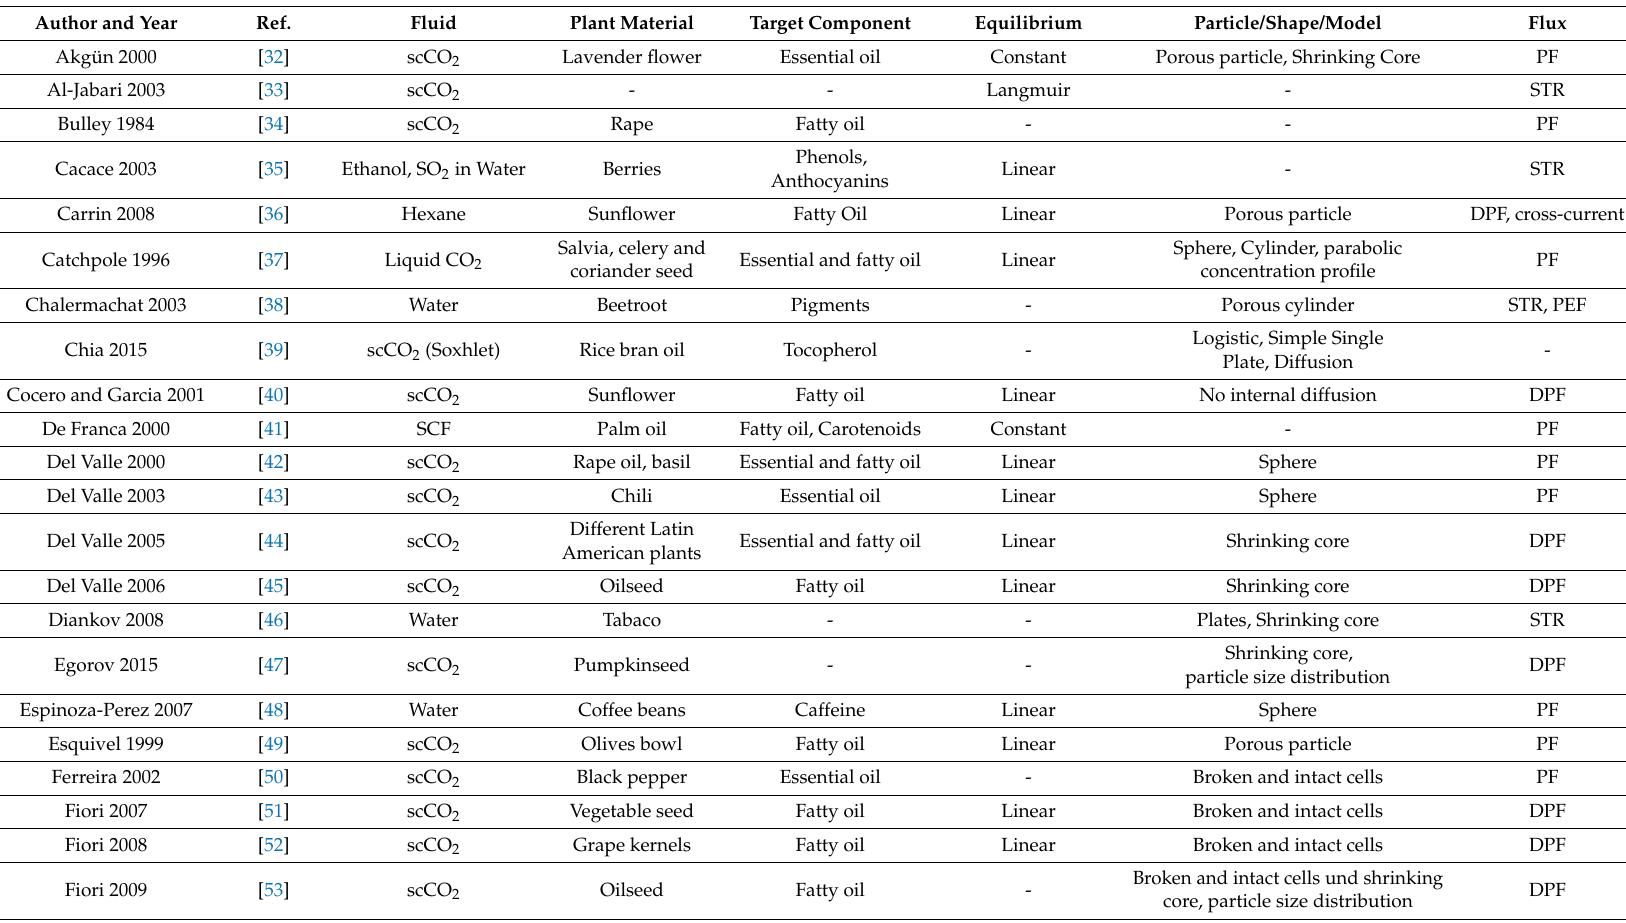
Table 1. Overview of modelling approaches, plug flow (PF), stirred tank reactor (STR), distributed plug flow (DPF), pulsed electrical field